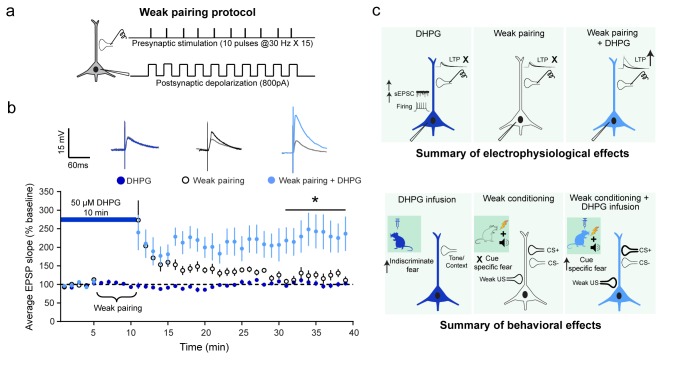
Although DHPG and a weak associative pairing protocol on their own did not elicit LTP, the two together caused a robust facilitation of LTP.(a) Schematic of the weak associative pairing protocol that involved pairing EPSPs evoked by presynaptic stimulation of thalamic afferents (trains of 10 pulses at 30 Hz, repeated 15 times) with weak postsynaptic depolarization of LA neurons (somatic injection of 800 pA current) timed to coincide with the peak of EPSPs evoked by presynaptic stimuli (see Materials and methods). (b) 10 min bath application of 50 µM DHPG (blue bar) alone did not induce LTP (, n = 11 neurons, p>0.05). The weak pairing protocol ( ⏟ ) caused only a transient enhancement in the EPSP slope, but no LTP (○, n = 11 neurons, p>0.05). However, in the presence of DHPG, the same weak pairing protocol induced robust LTP (, n = 12 neurons, *p<0.05). Superimposed representative EPSP traces before (grey) and30 minutes after the three manipulations – DHPG alone (dark blue), weak pairing alone (black), and weak pairing + DHPG (light blue). (c) Summary of the electrophysiological effects of in vitro activation of mGluR5 in LA slices and how they relate to the behavioral effects of in vivo activation of mGluR5, as described in the text.DOI:
http://dx.doi.org/10.7554/eLife.25665.01010.7554/eLife.25665.011Figure 3—source data 1.Data for individual cells representing the EPSP slope, normalized to baseline with DHPG treatment, weak pairing and weak pairing in the presence of DHPG (Figure 3b).